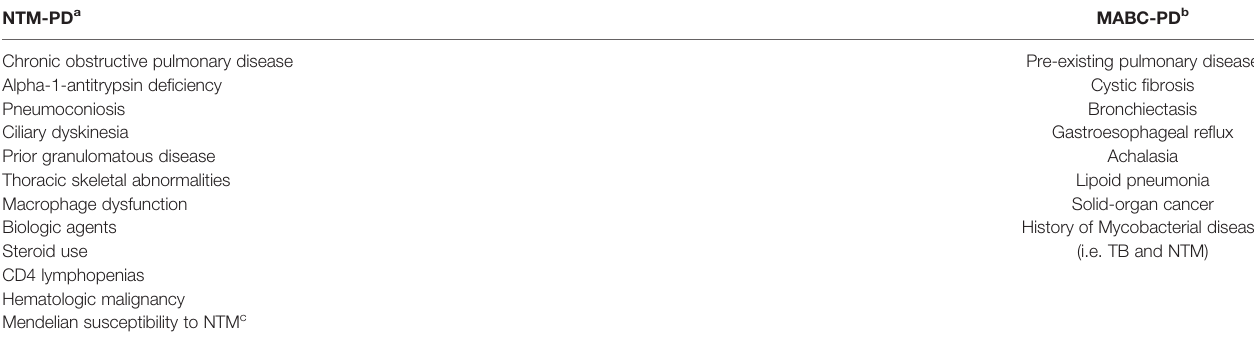
TABLE 1 | Risk factors associated with non-tuberculous mycobacterial pulmonary disease. NTM-PD